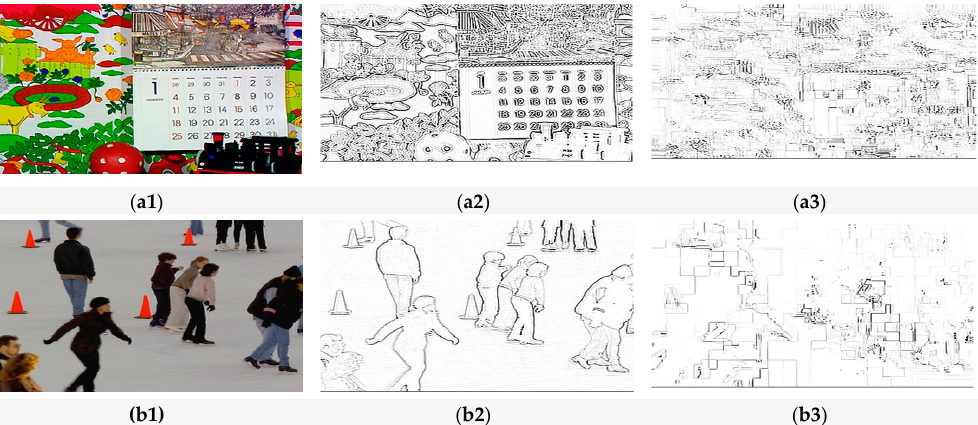
Figure 6. The comparative visual impact of EXPer on ICE and mobile video sequences after Laplacian edge detector. ( a1 ) Plaintext mobile video frame; ( a2 ) detected edges of plaintext mobile video frame; ( a3 ) detected edges of encrypted mobile video frame; ( b1 ) plaintext ICE video frame; ( b2 ) detected edges of plaintext ICE video frame; ( b3 ) detected edges of encrypted ICE video frame.